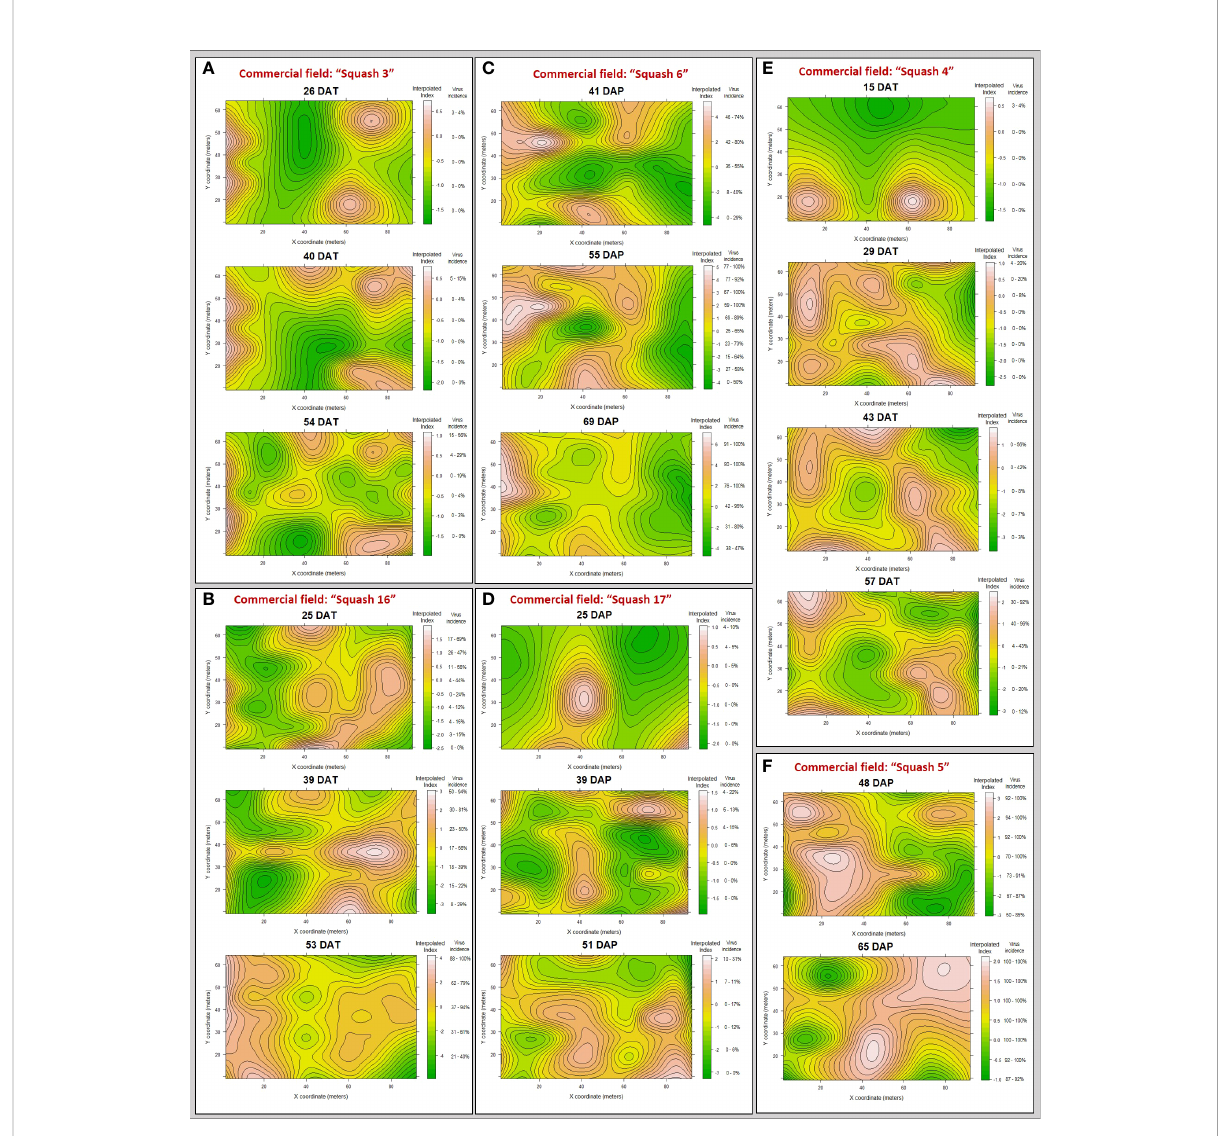
FIGURE 7 Maps of clustering indices with interpolated landscape and contours showing areas within commercial squash fi elds surveyed, in 2019 (A, C, E, F) and 2020 (B, D) , where WTVC infected plants occurred as patches (red to white areas) or gaps (green areas) based on the interpolated index from the SADIE